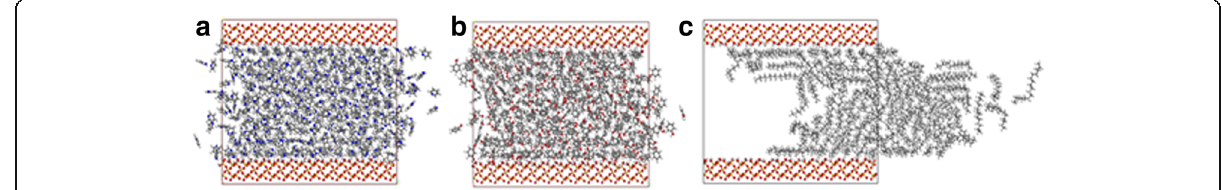
Fig. 7 Snapshots of a pyridine, b phenol, and c octadecane transportation in 4 nm silica channels at 2 ns